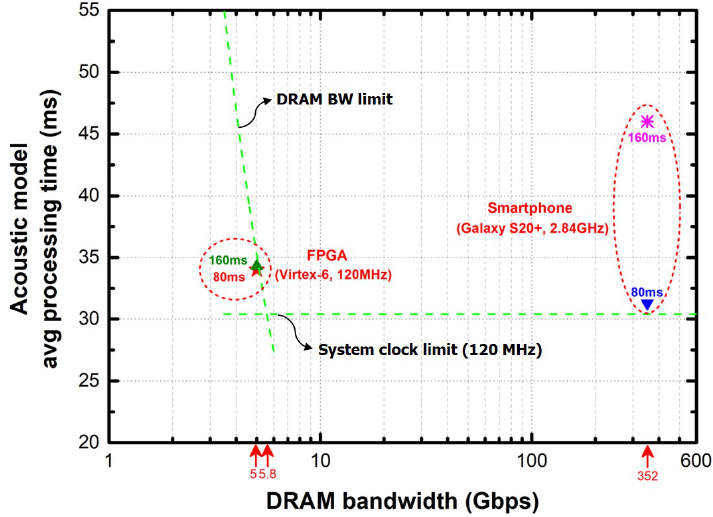
Figure 9. Comparison of processing time of a unit input between the hardware and software AMs.